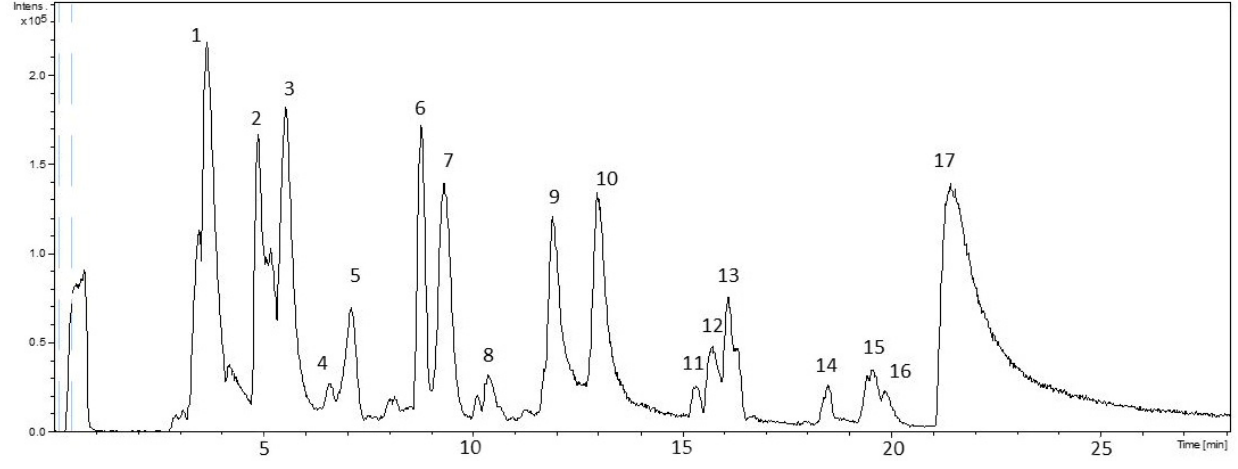
Figure 1. HPLC-ESI-TOF-MS chromatogram of the PPP. Table 3. Proposed compounds tentatively identified in pomegranate peel powder by HPLC-ESI-TOF- MS. The numbers correspond to the peaks illustrated in Figure